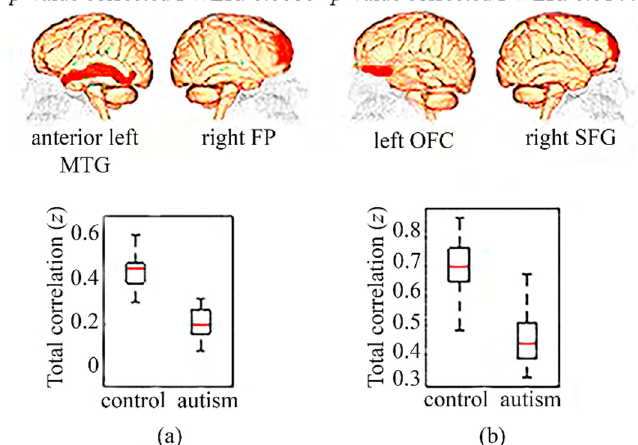
Figure 2. Hypoconnectivities in children (<12 years old) with autism compared to controls, from the NYU center. ( a ) Boxplot showing full correlation values between anterior left MTG and right FP in controls and autists; ( b ) Boxplot showing the full correlation values present in controls and autists between the regions left OFC and right SFG. FP: frontal pole; MTG: middle temporal gyrus; NYU: New York Langone Medical Center; OFC: orbitofrontal cortex; SFG: superior frontal gyrus.